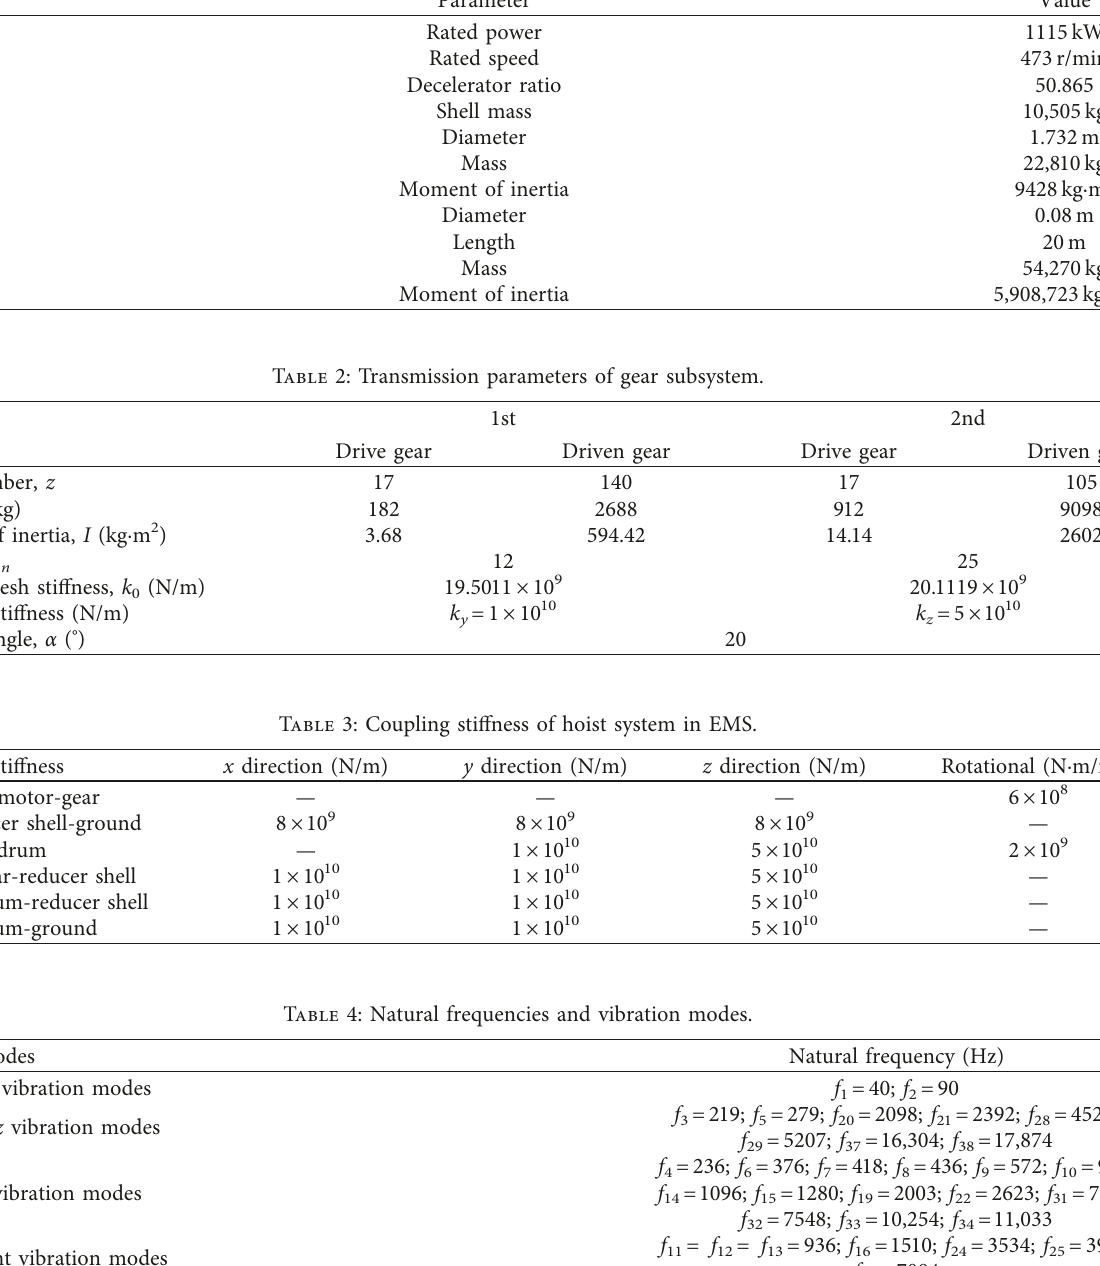
and 2 f in dm dm